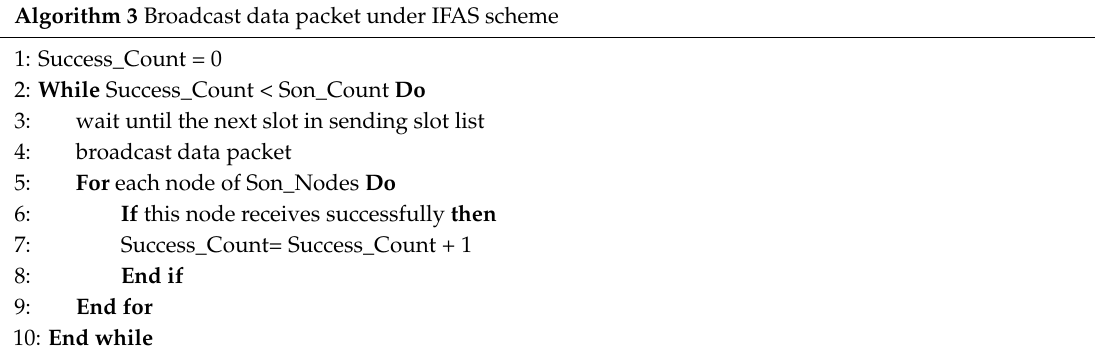
Algorithm 3 Broadcast data packet under IFAS scheme